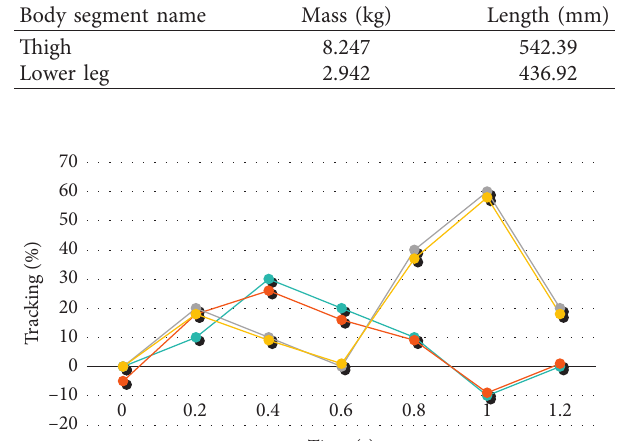
Table 3: Size and mass of lower limbs.